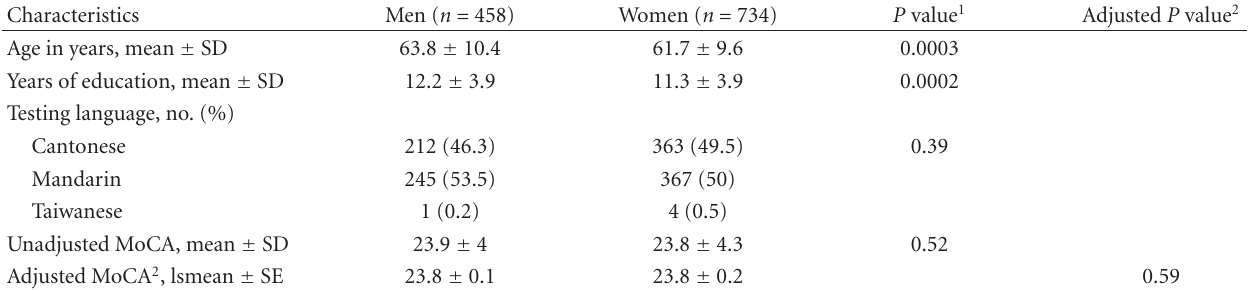
Table 5: Comparisons of age, education, testing language, and MoCA-ChLA scores between men and women. Characteristics